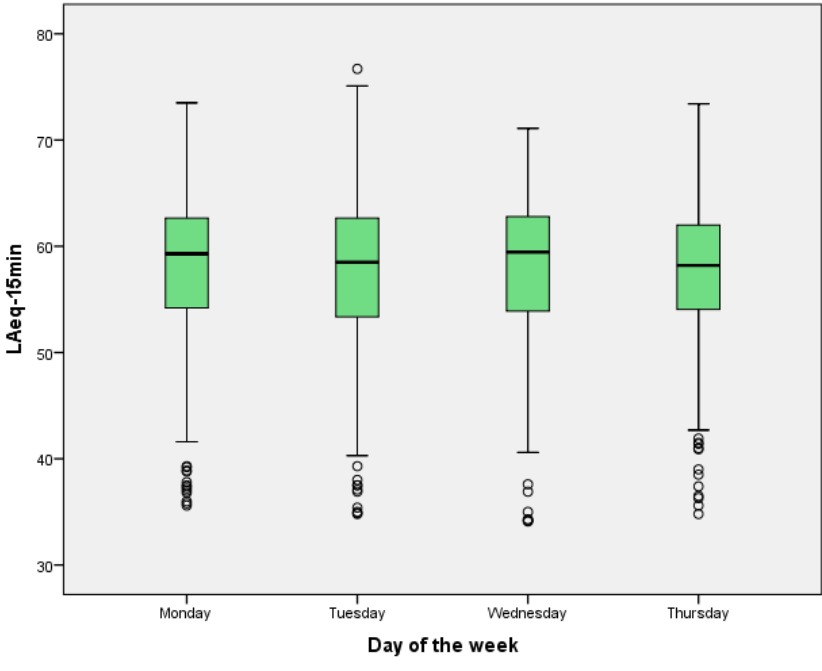
Figure 5. Distributions of L Aeq-15min scores as a function of the day of the week.